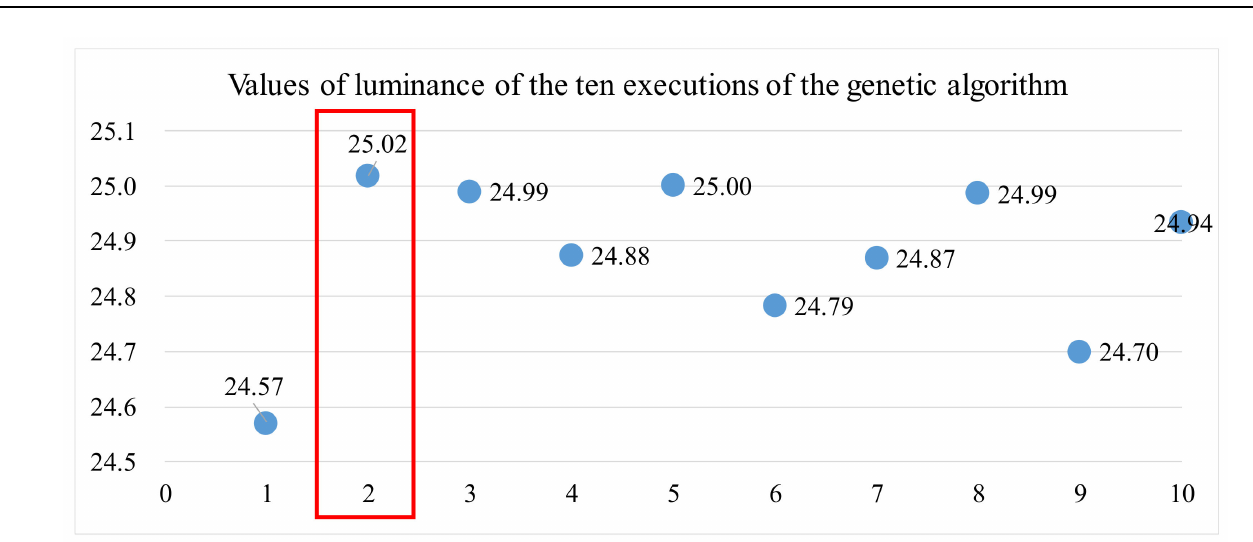
Figure 16. Luminance values of the ten executions of the genetic